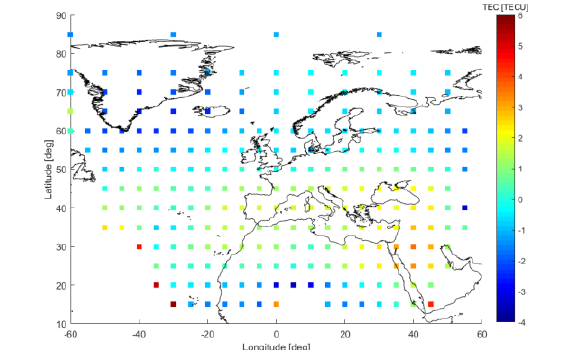
Figure 8. Annual average discrepancies between EGNOS and CODE model in